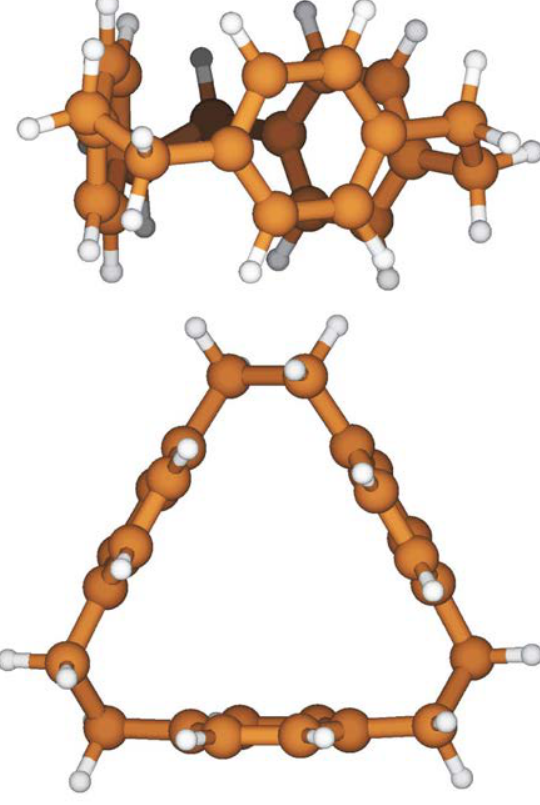
Figure 4 . Two projections of the DFT optimized structure of free [2.2.2]paracyclophane (ω-B97XD / def2-TZVP).